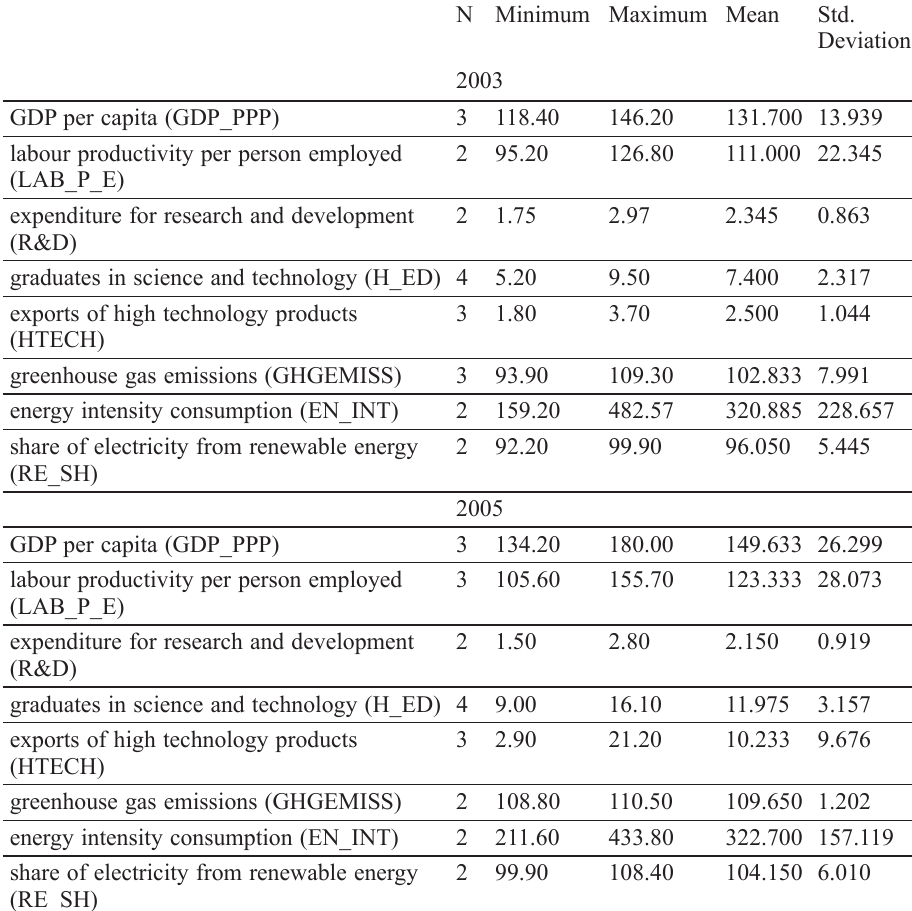
Table 5. Descriptive statistics of the analyzed structural indicators’ variables for the EFTA-4 countries in 2003 and 2005 N Minimum Maximum Mean